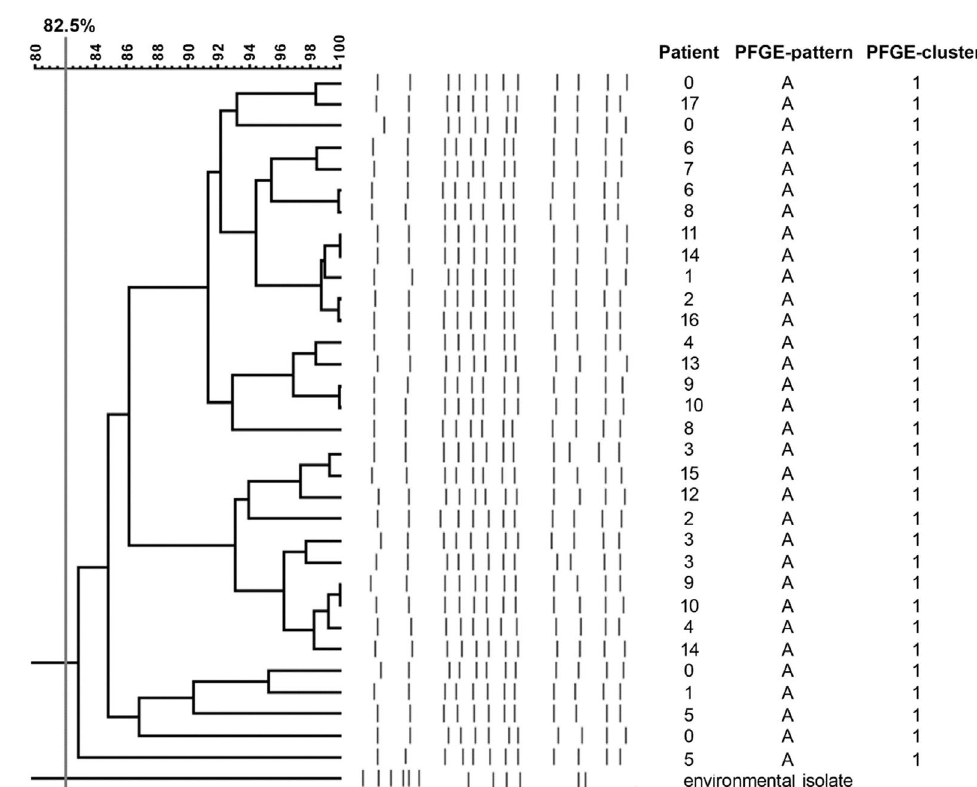
Figure 2. Pulsed-field gel electrophoresis of extended-spectrum β -lactamase-producing Klebsiella pneumoniae strains isolated from an outbreak in the Neonatal Clinic.